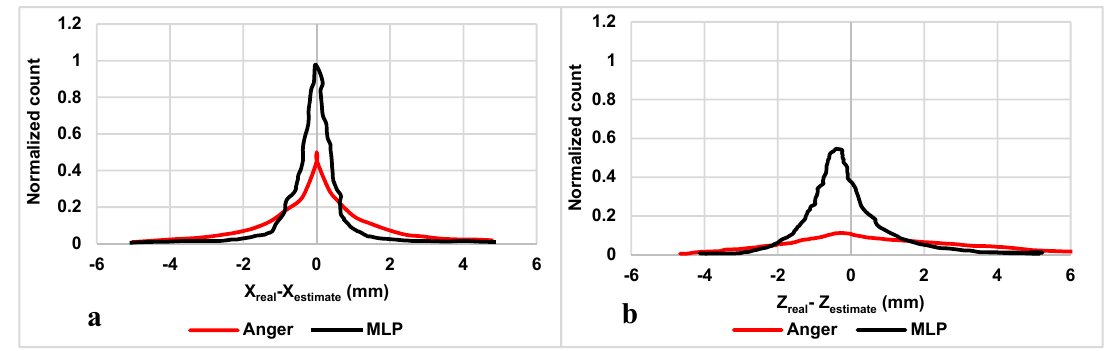
Figure 3. The normalized histograms of the estimation error along ( a ) XY plane and ( b ) Z -axis (DOI) from the validation dataset.